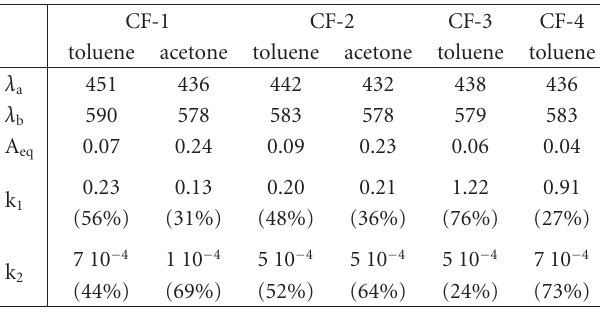
Table 2: Maximal absorption wavelengths of the colored forms ( λ a and λ b ), colorability (A eq ), fading rates (k 1 and k 2 ) of CF-1 and CF- 2 in toluene and acetone and of CF-3 and CF-4 in toluene solutions under continuous irradiation (10 − 4 M at 20 ◦